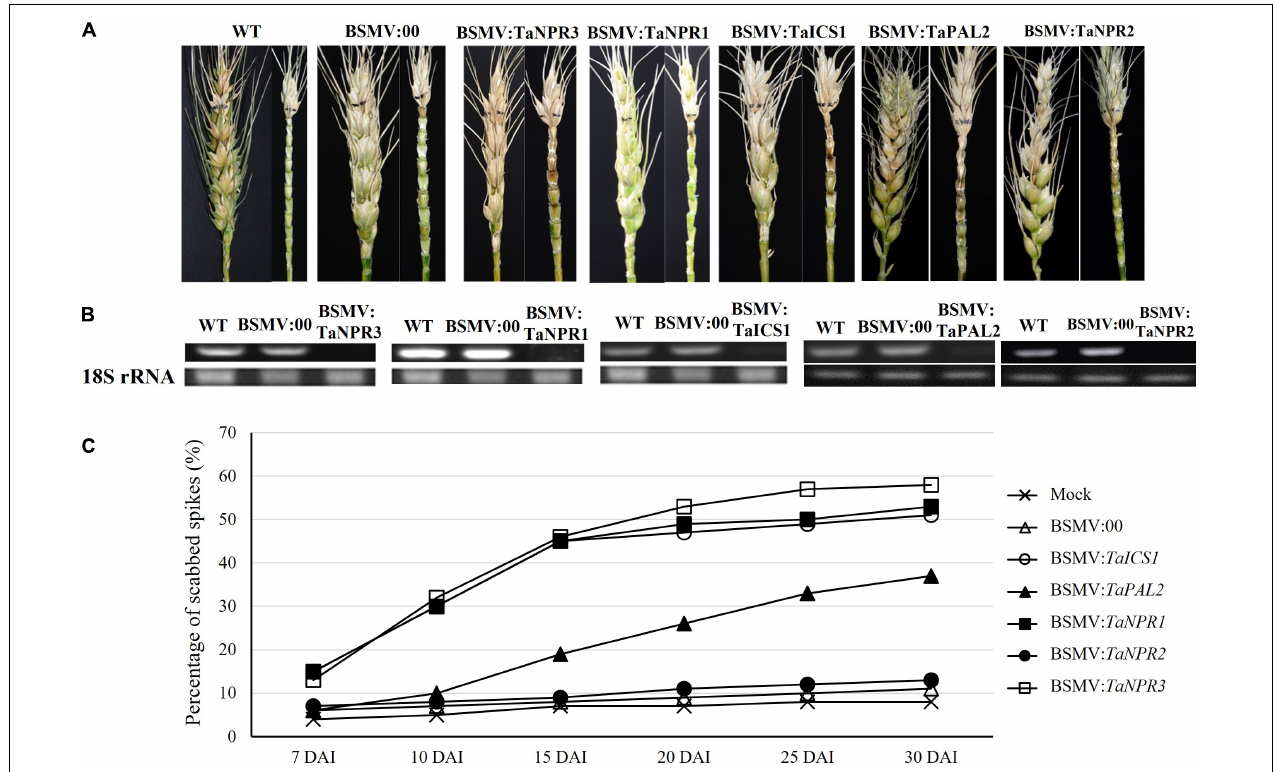
FIGURE 6 | Effects of the five genes in SA pathways and signaling that were silenced by barley stripe mosaic virus -mediated gene silencing (BSMV-VIGS) from Sumai 3 on FHB resistance. (A) FHB symptoms on wheat spikes with BSMV-VIGS silenced genes. (B) Gene expression profiles for the five VIGS-treated genes in wheat spikes were evaluated by semi-quantitative RT-PCR. The wheat 18S rRNA gene was used for endogenous reference for normalization. Each treatment had three biological replicates, and each biological replicate had three technical replicates. (C) The percentage of scabbed spikelets in the spikes with and without VIGS-silenced genes from Sumai 3 at 7, 10, 15, 20, 25, and 30 days after inoculation (DAI). BSMV:00, BSMV with blank